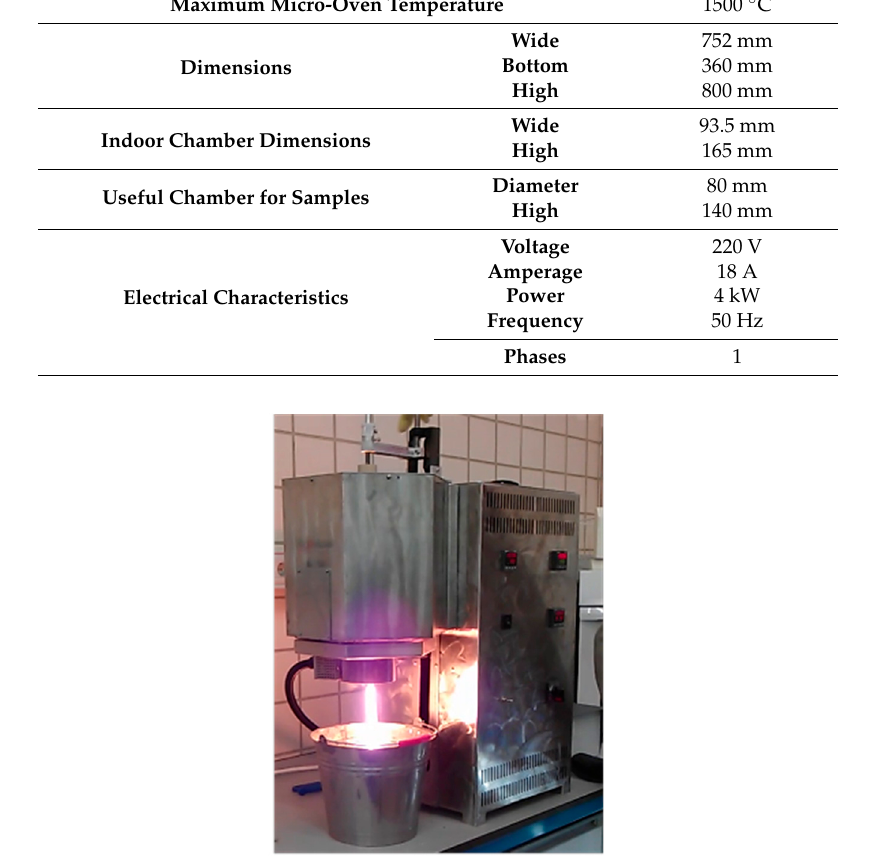
Figure 2. Furnace and cooling system.